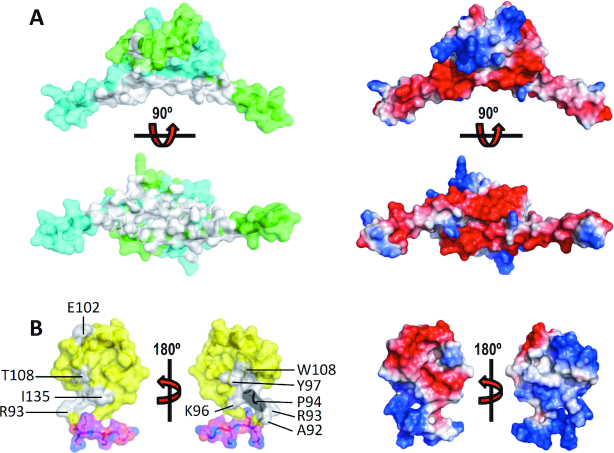
The H-NS C-terminal region binds to the N-terminal domain. (A) Left: Chemical shifts (grey) mapped on H-NS2–57 chains A (green) and B (cyan). right: electrostatic surface of H-NS2–57. Top and bottom panels show 90° views. (B) Left: Chemical shifts (grey) mapped on H-NS84–137. Proline 94 is shown in black. Yellow: DNAbd; magenta: linker residues 84–90. Right: electrostatic surface of H-NS84–137. For each representation, 180° views are shown, as indicated.